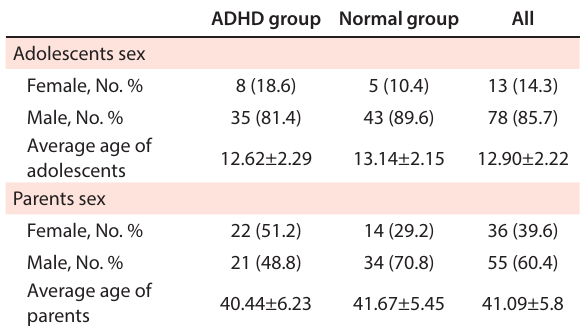
Table 1. Demographic information of participants and their parents in this study ADHD group Normal group